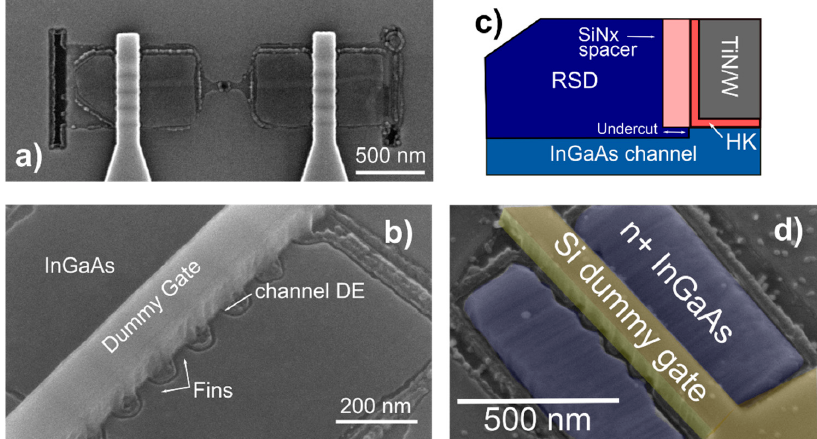
Figure 2. Device fabrication steps. ( a ) Top ‐ view SEM image of InGaAs FinFET device after dummy gate patterning and dry etch. Fins are visible underneath the gate. ( b ) SEM picture showing InGaAs